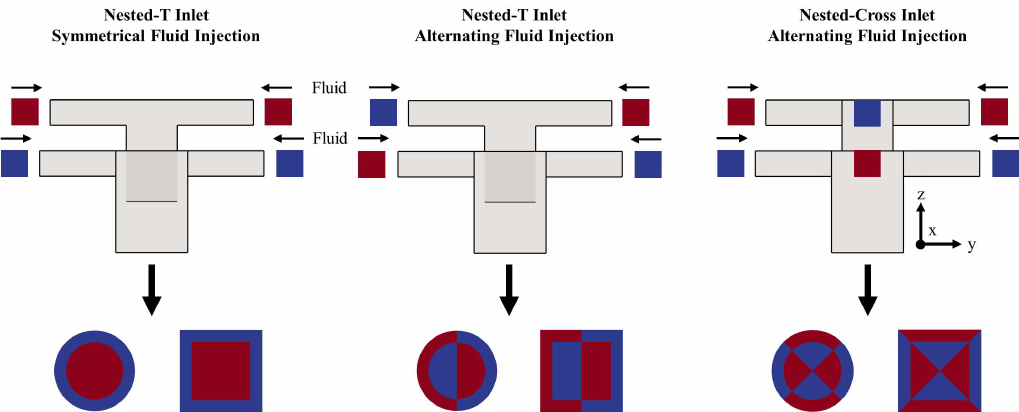
Figure A2. Formation of concentric flows with symmetrical and alternating fluid injections over the nested-t and nested- cross inlet structures. Circular and rectangular planes show the distribution of fluids in concentric flows. Red and blue colors represent different